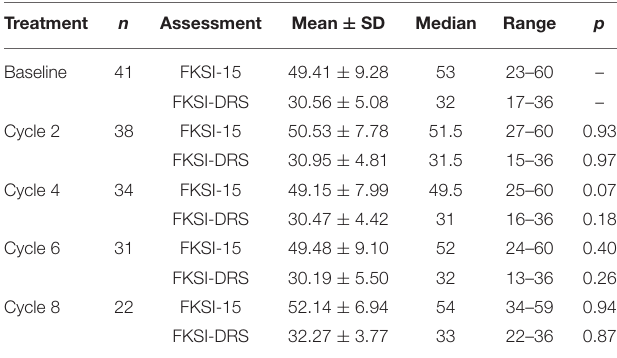
TABLE 2 | Assessment of the quality of life after anlotinib treatment by FKSI-15 and FKSI-DRS scoring. Treatment